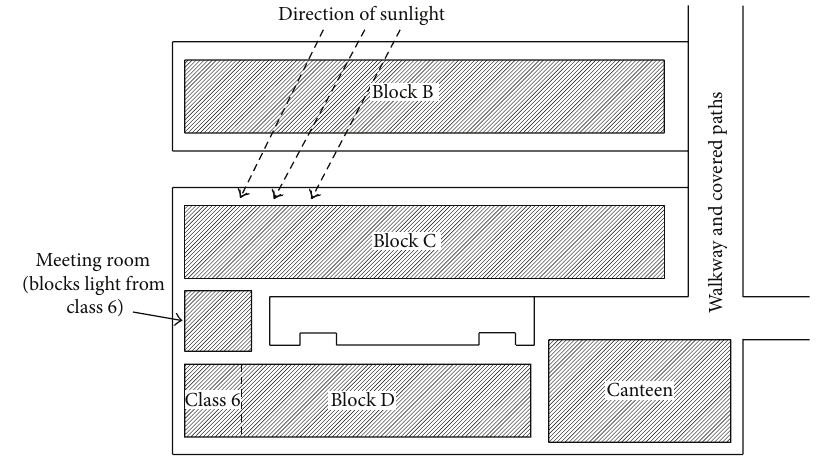
Figure 2: Partial view of the school’s architectural layout.